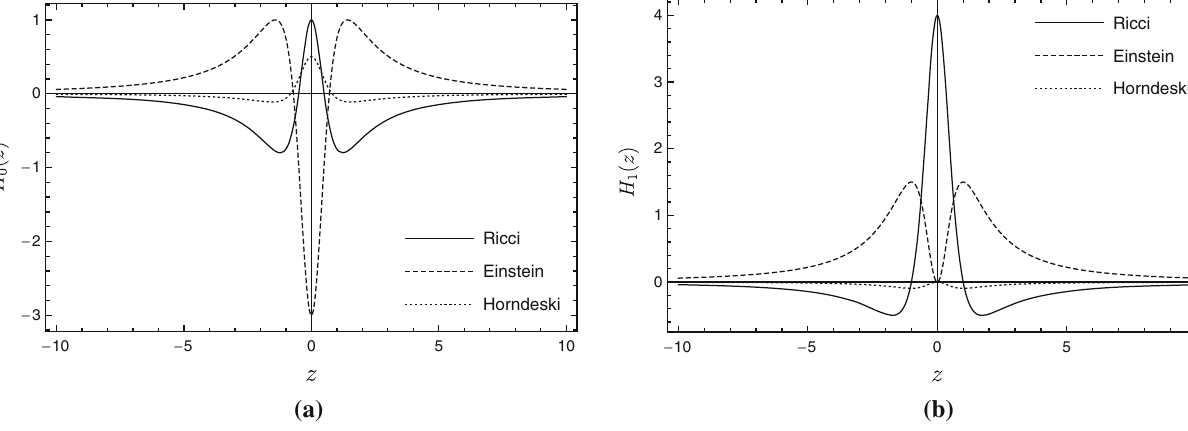
near E = 0 . 5 and near E = 14 with λ = − 5 for Riemann